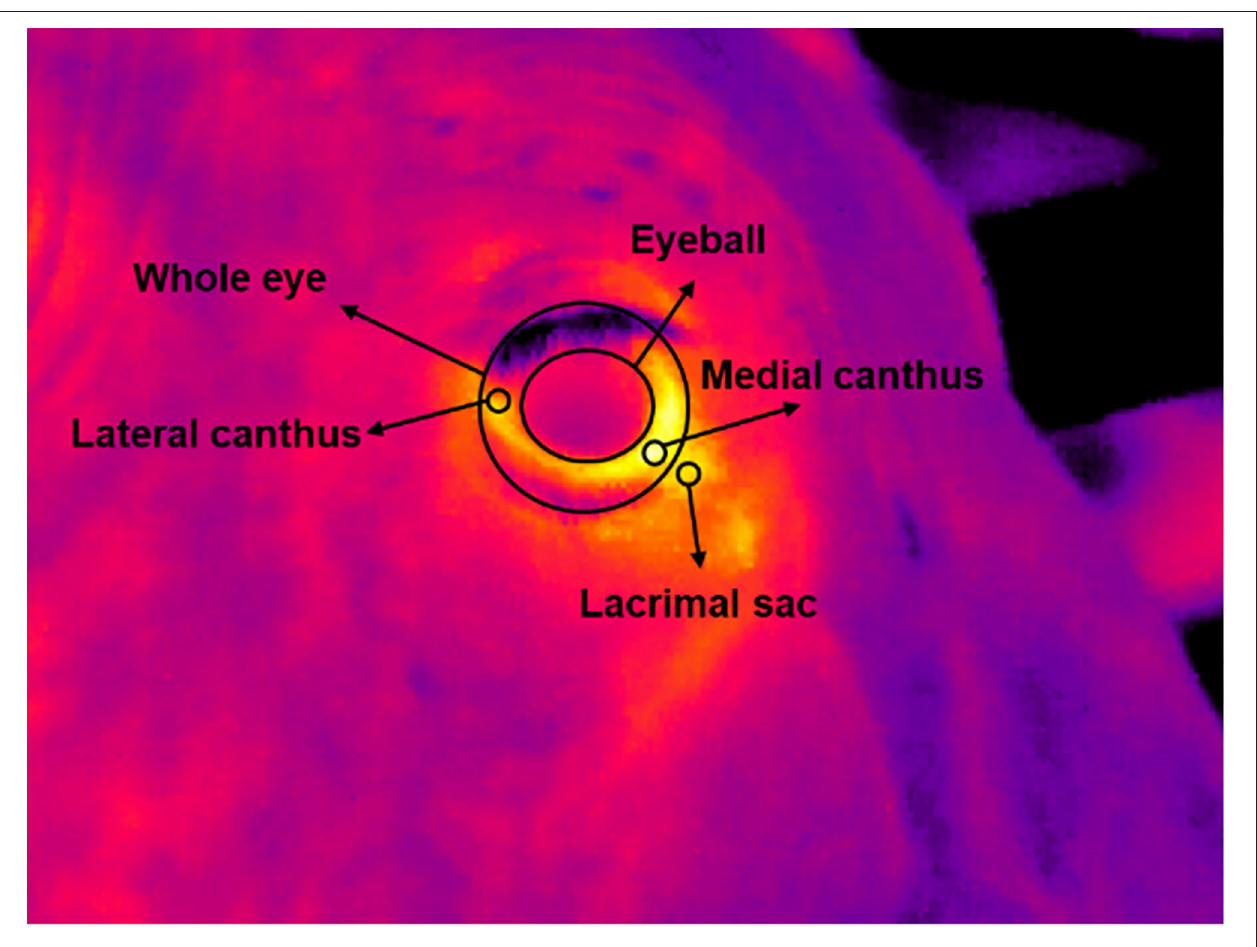
FIGURE 1 | Five regions of interest of eyes for temperature